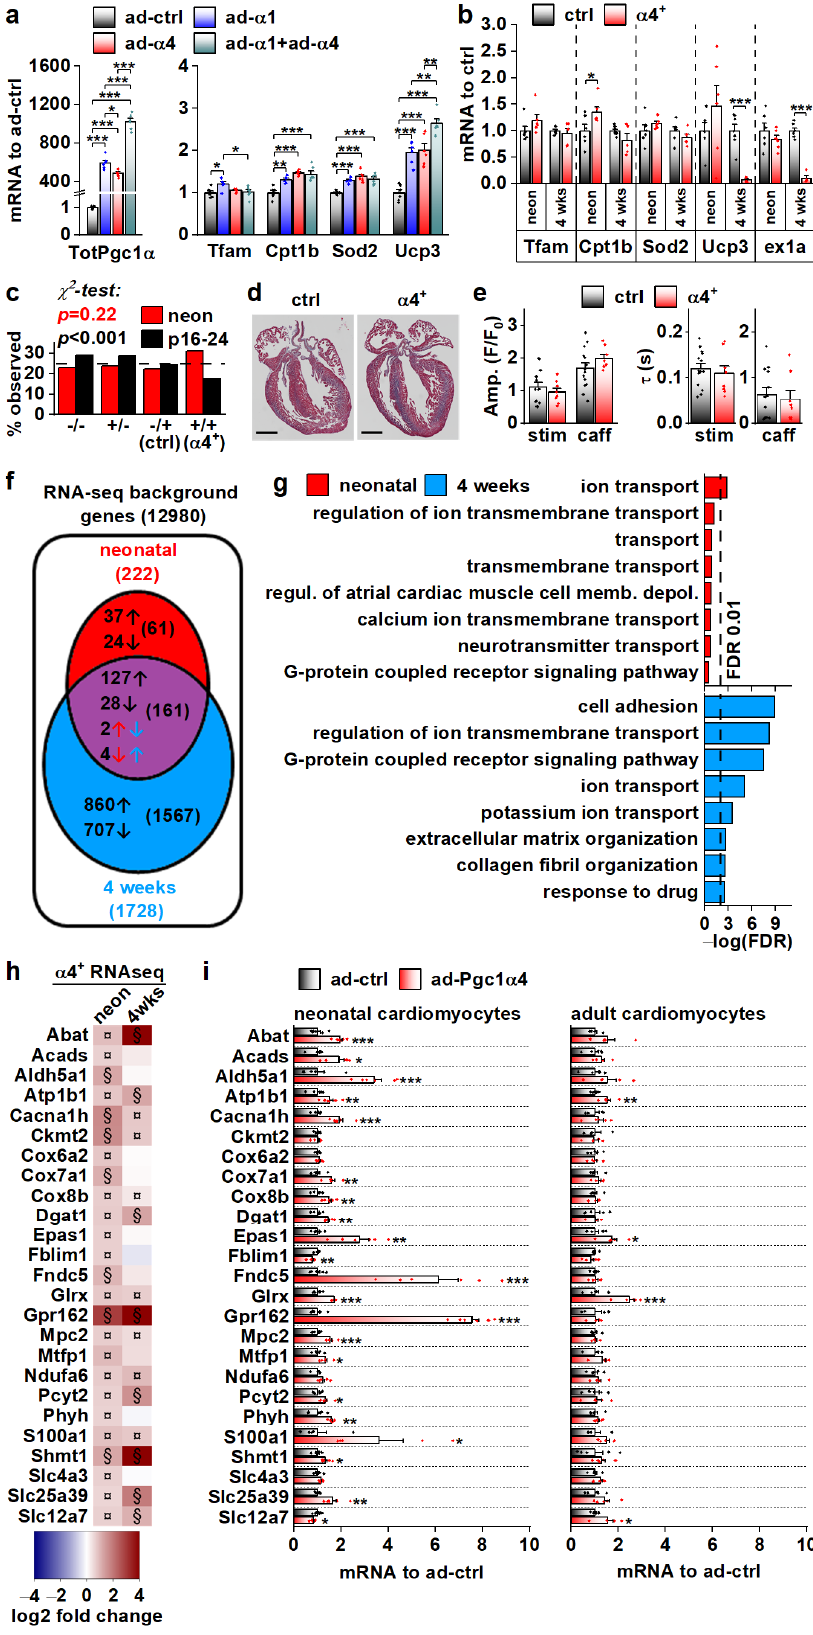
Figure 4. PGC-1 α 4-induced Gene Expression Response and the Resulting Phenotype Depend on Cardiomyocyte Developmental Stage. ( a ) Expression of total Pgc-1 α and known PGC-1 α 1 target